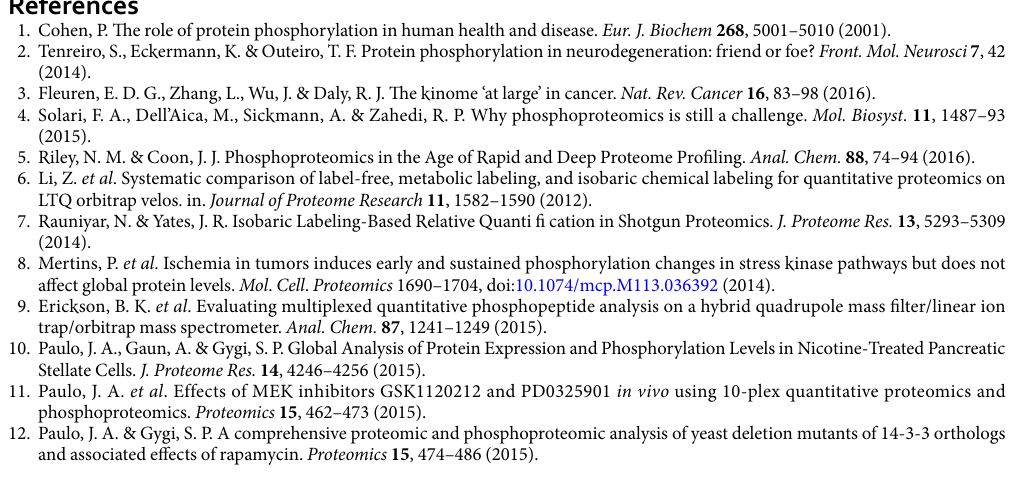
related genes corresponding to novel putatively functional phosphorylation